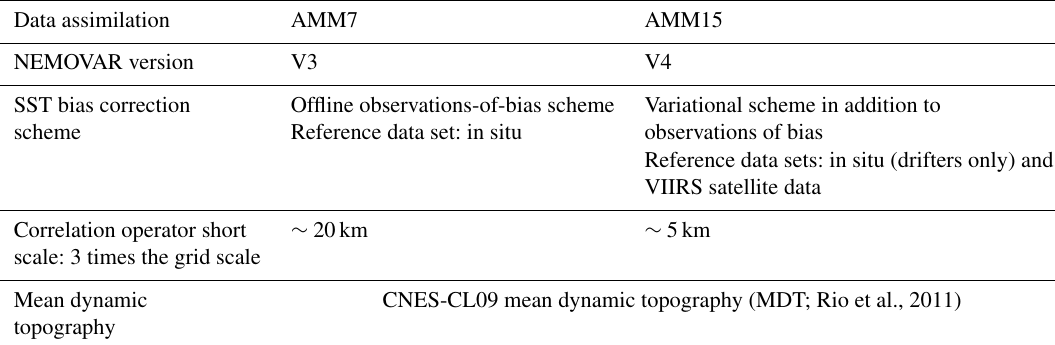
Table 4. AMM15–AMM7 differences in the data assimilation